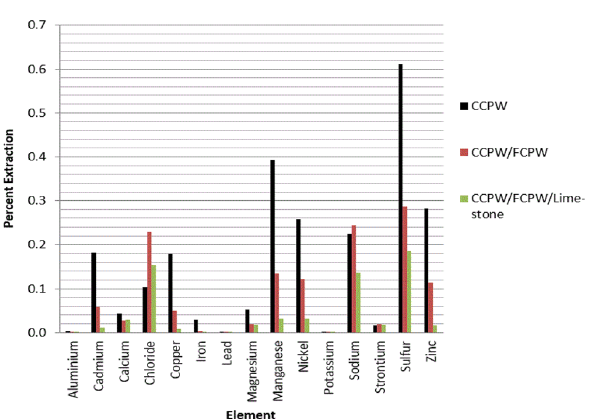
Fig. 6 Elemental extraction during 19-month kinetic